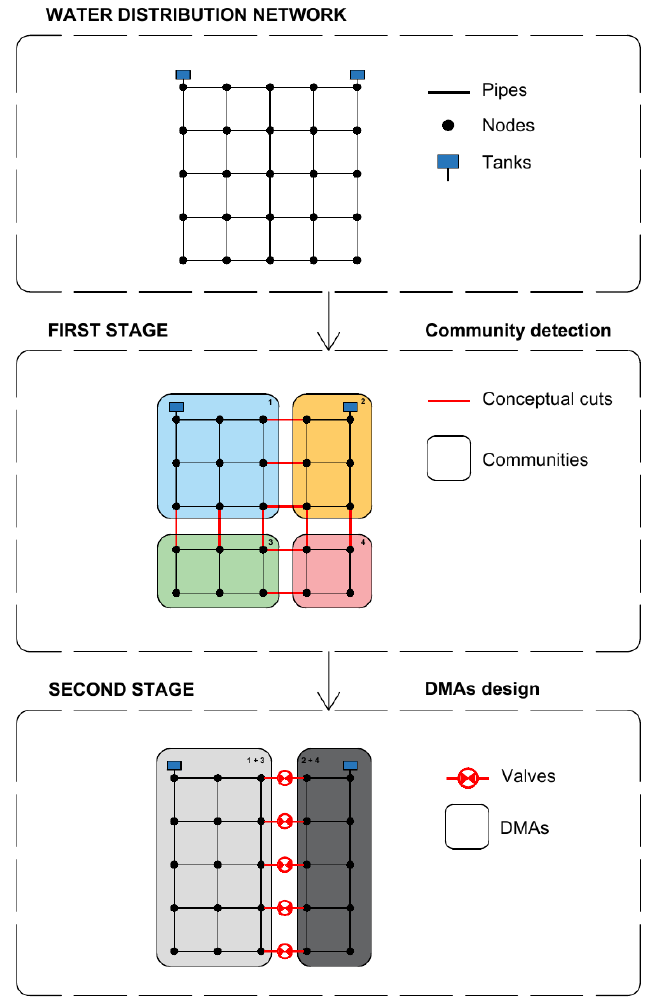
Figure 1. Schematic process of district metering areas (DMAs) design for a simple